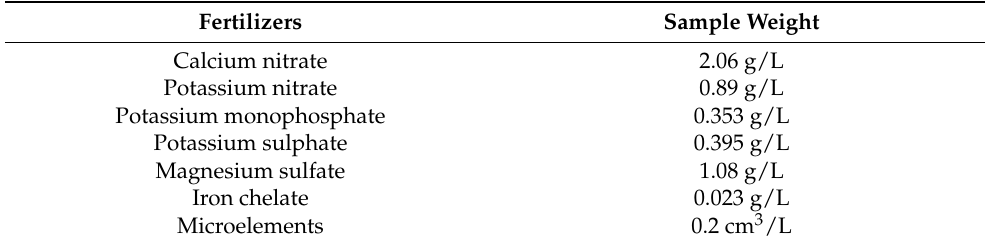
Table 2. The composition of the synthetic wastewater.